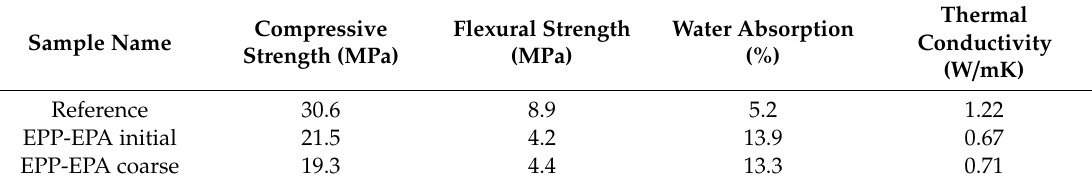
Table 7. Mechanical and thermal properties of bricks.